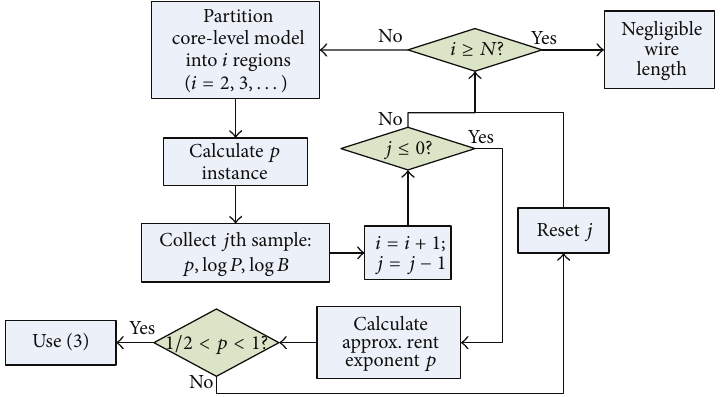
Figure 9: CMD routing estimation flow ( 𝑁 = total number of core